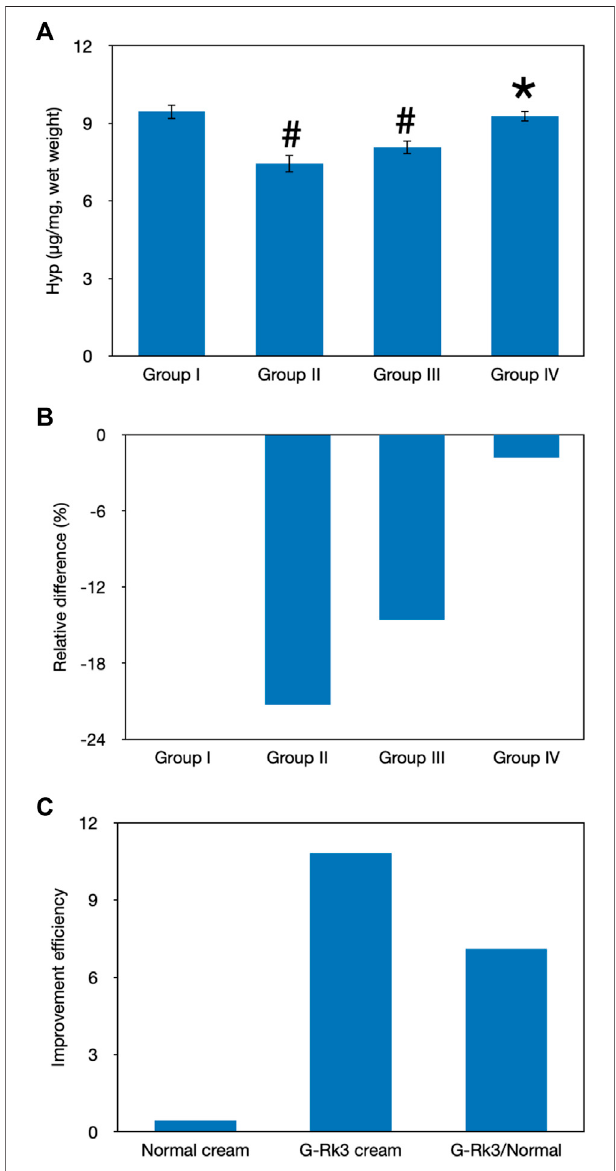
FIGURE8| Evaluation ofskincollagen.TheabsolutevalueofHYPlevels (A) . #Signi fi cantly different from group I, p < 0.05. *Not different from group I, p > 0.05. Relative differences in the four groups (B) . Improvement ef fi ciencies of normal and G-Rk3 creams (C) .